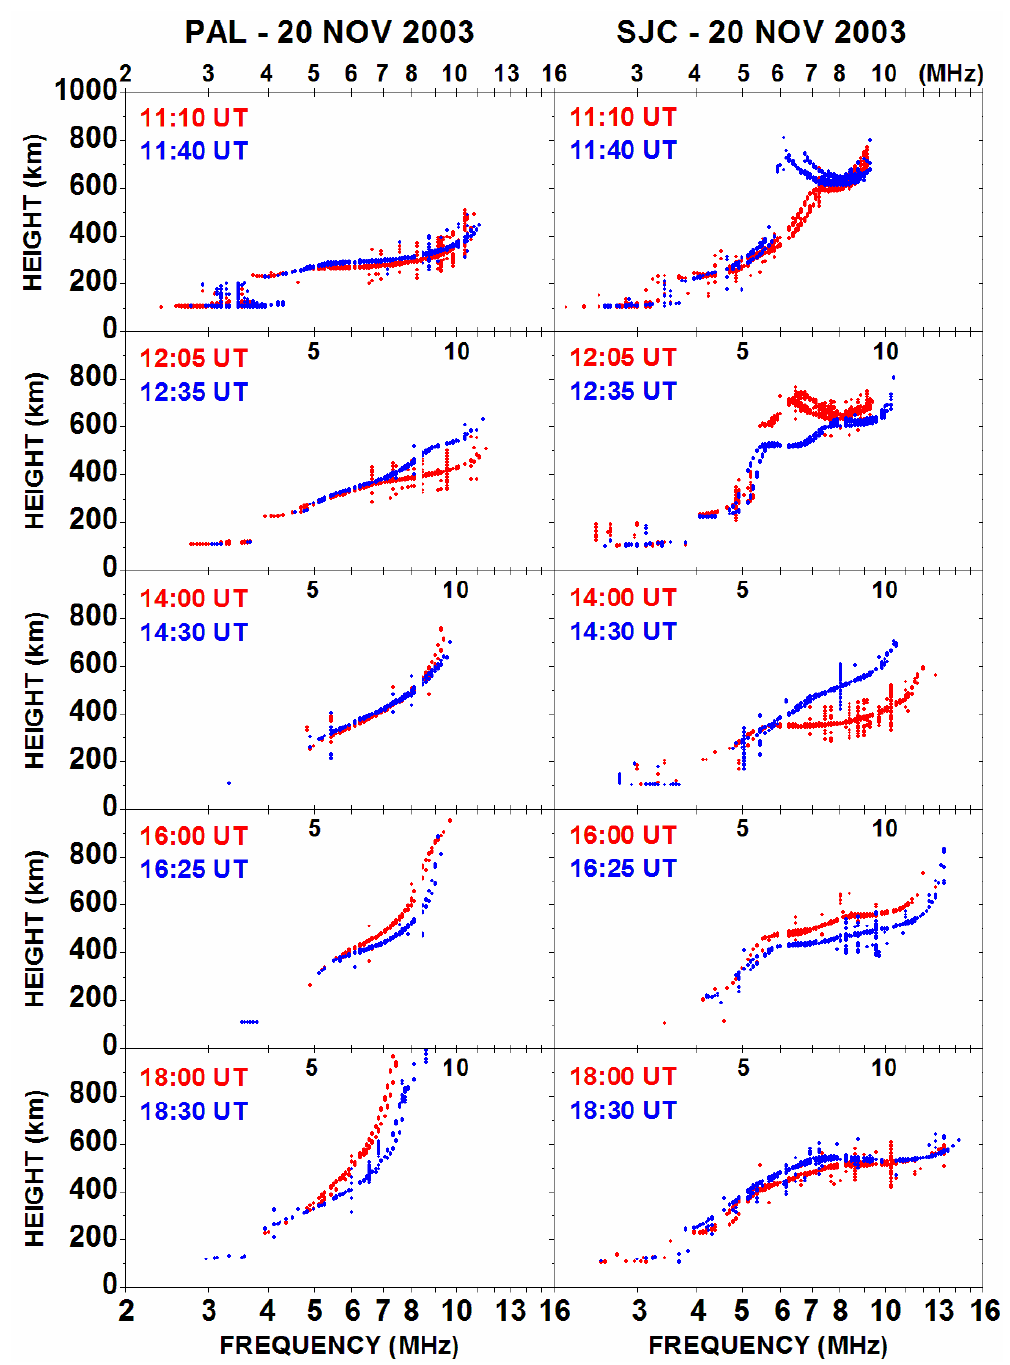
Fig. 5. A set of ionogram combinations obtained at times separated by about 30min at PAL and SJC on 20 November, which included the main phase of the